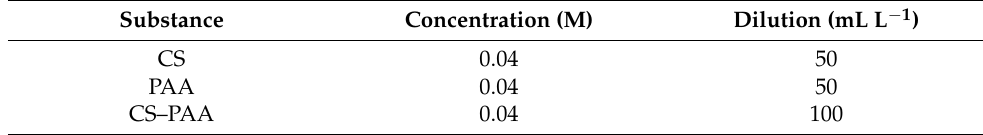
Table 1. Preparation of foliar applications.